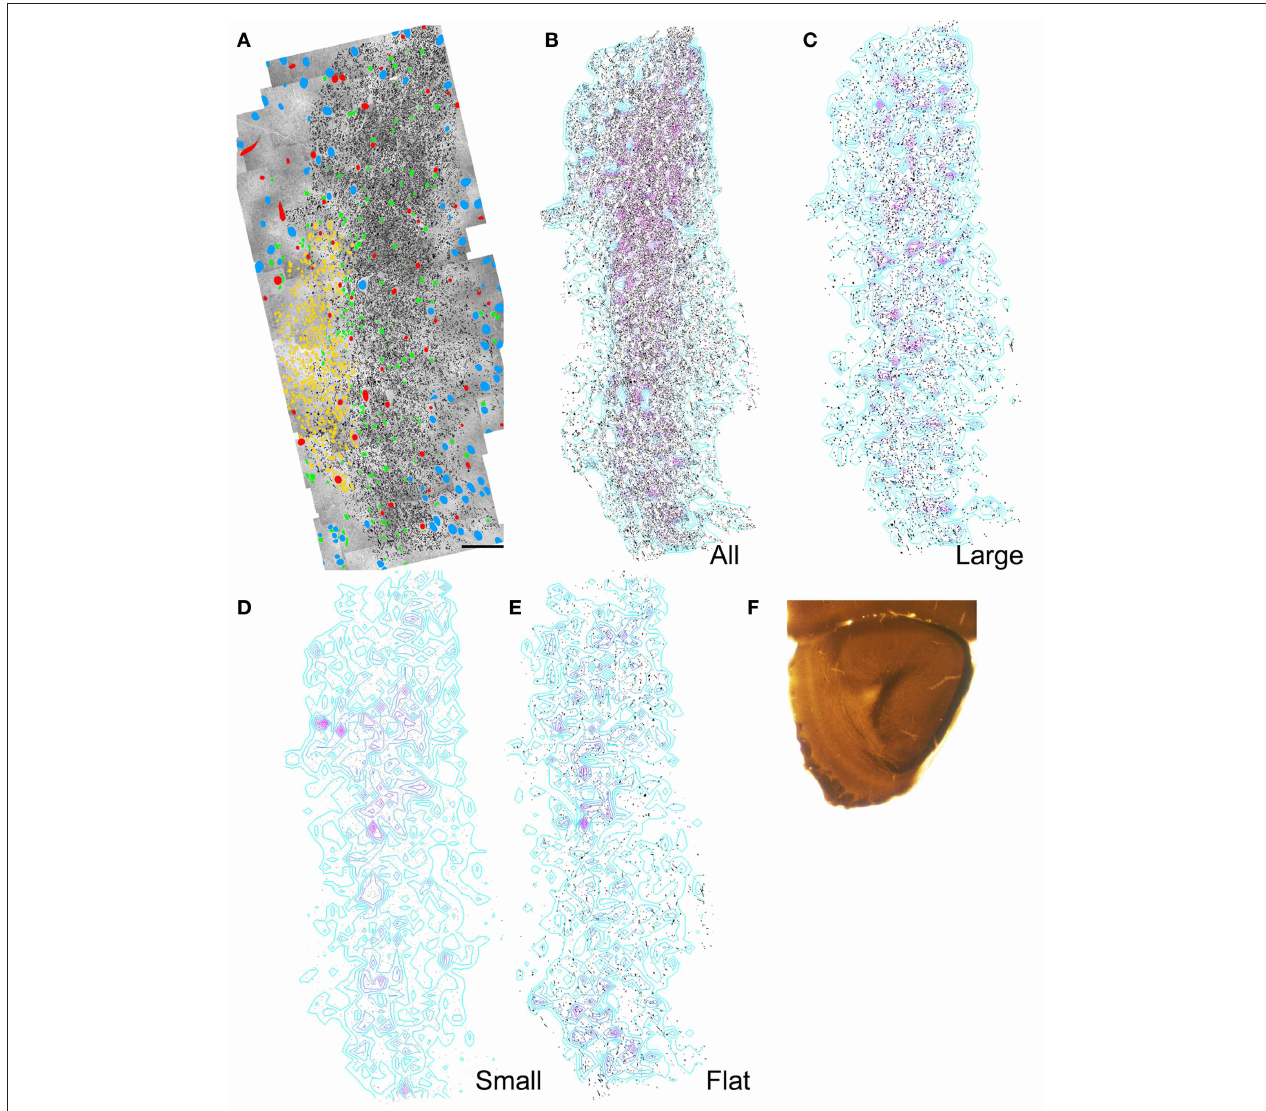
FIGURE 4 | Results of electron microscopic study of myelinated axons in the anterior olfactory peduncle. (A) Montages of electron micrographs through the center of the peduncle were constructed. Every myelinated axon in or near the ALAC was outlined and filled with black. The location of neuronal nuclei (blue), blood vessels (red), SVZ cells (yellow), and glial nuclei (green) are marked. Medial to left, dorsal to top. Scale bar: 50 μ m. (B) Same as panel (A) with only the axons shown.